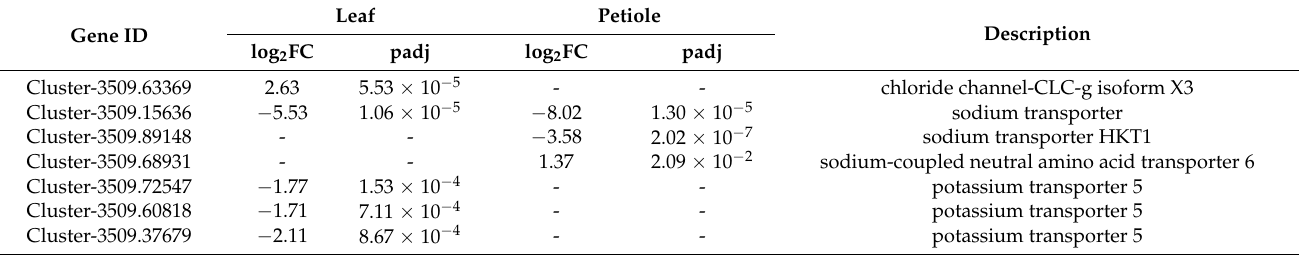
Table 2. DEGs involved in ion and water transport in the leaves and petioles of water lilies under salt